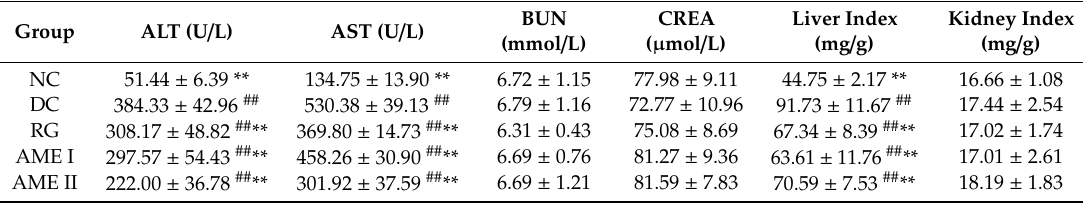
Table 5. E ff ects of AME on the level of ALT, AST, BUN and CREA in serum and liver index and kidney _ index in diabetic mice ( x ± SD, n =